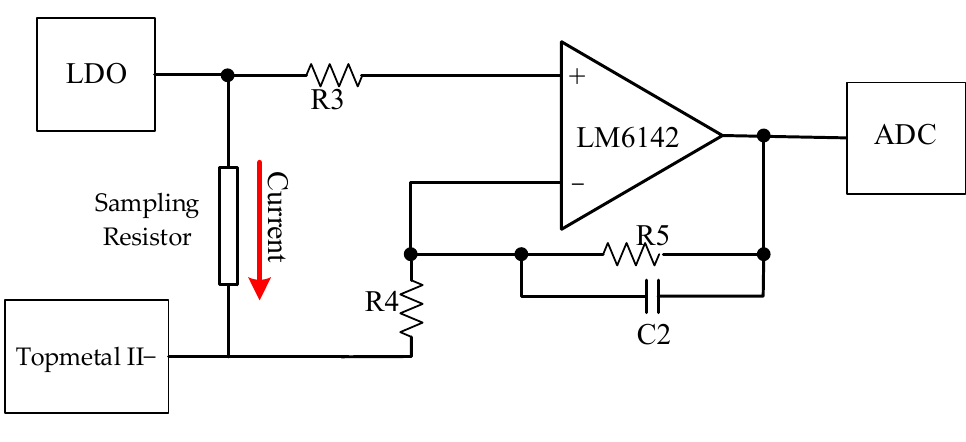
Figure 8. The Current Monitoring Circuit.